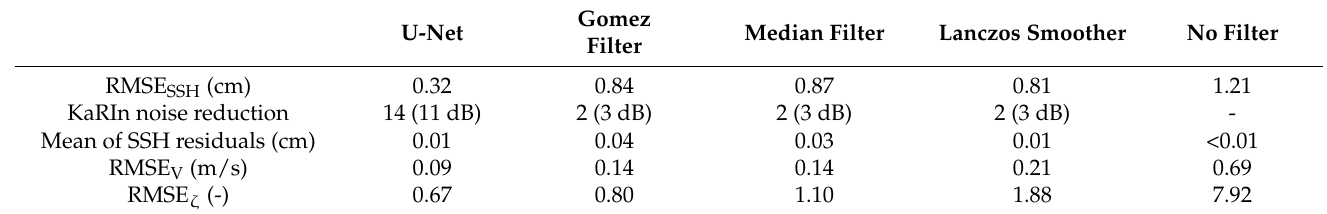
Table 2. Comparison of the coastal (<10 km to the coast) scores between the U-Net, the classical methods and with no filtering computing on the entire domain.